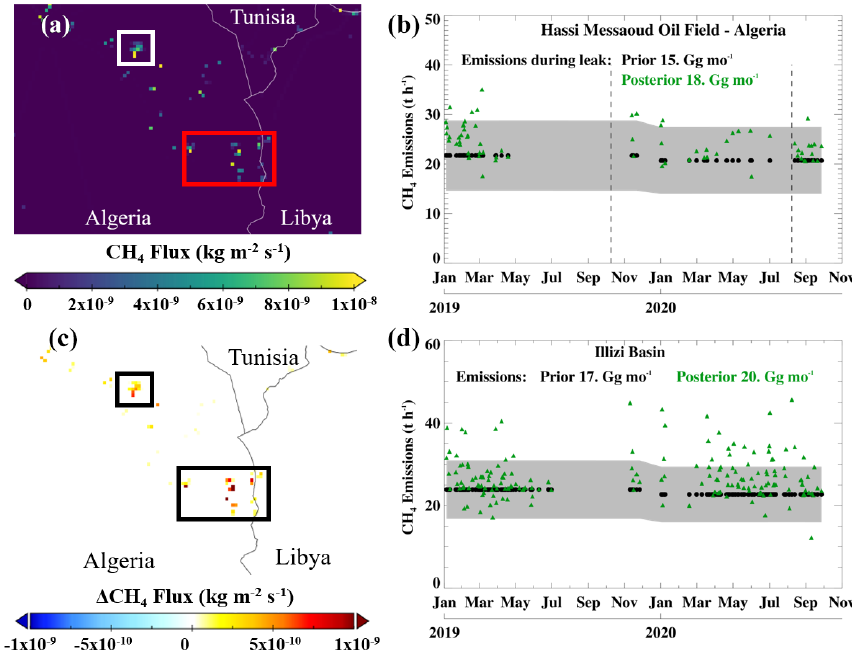
Figure 9. (a) Prior average anthropogenic CH 4 emissions for Eastern Algeria, 2019. The domains for the Hassi Massaoud oil field (1 ◦ × 1 ◦ , white box) and part of the Illizi Basin (3 ◦ × 1 . 5 ◦ , red box) are marked. Time series of total prior (black circles) and posterior (green triangles) CH 4 emission estimates within the Hassi Massaoud (b) and Illizi Basin (d) domains for 2019–2020, where observations and inverse simulations were available. The shaded error denotes prior uncertainty. (c) Average posterior minus prior CH 4 emissions for January– June 2019, using dates where nearby observations were